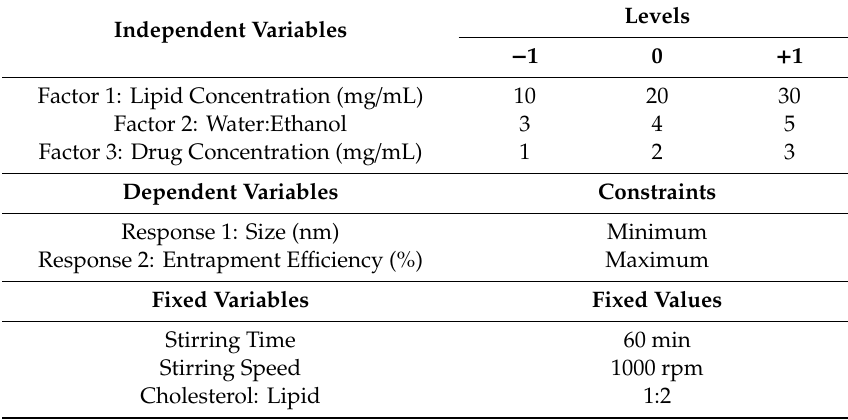
Table 2. Design of Experiment (DOE) Variables (First level).